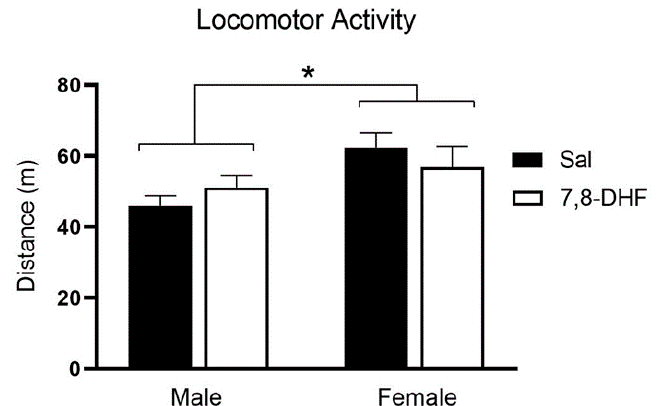
Figure 4. Average spontaneous locomotor activity during a 20-min post-reinstatement session. Rats received either 10 mg/kg 7,8-DHF or sham injection 50 min prior to locomotor testing. Female rats showed higher spontaneous locomotor activity than male rats but there were no differences between 7,8-DHF-treated and vehicle-treated rats. Data are mean ± SEM; * = p < 0.05 for difference between males and females.